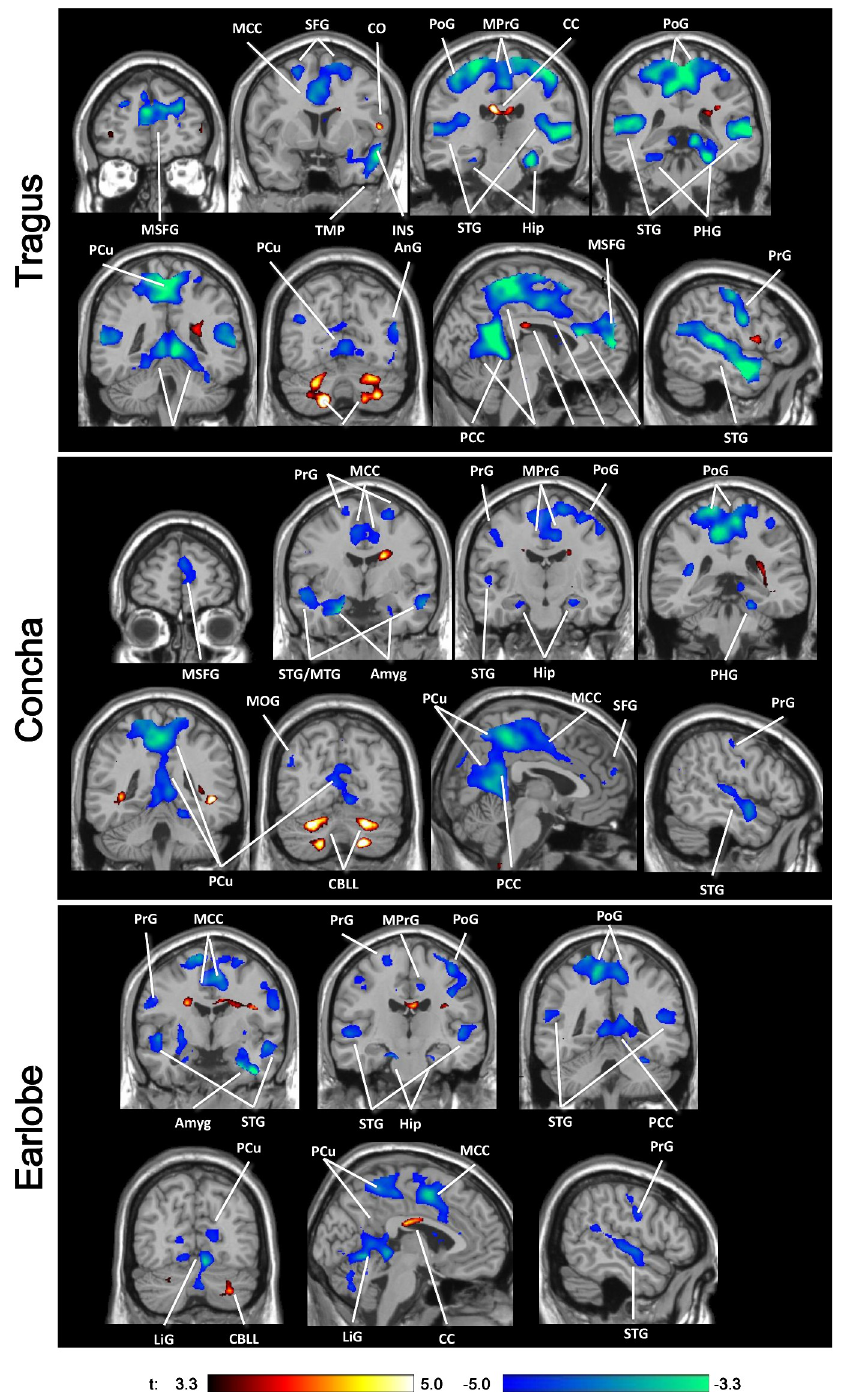
Fig 1. Activations (red) and deactivations (blue) induced by tVNS at the tragus, cymba conchae, and earlobe (p < 0.05, cluster corrected for multiple comparisons). tVNS: transcutaneous vagus nerve stimulation; ACC/MCC/ PCC: anterior/middle/posterior cingulate cortex; Amyg: amygdala; AnG: angular gyrus; CC: corpus callosum; CBLL: cerebellum; FuG: fusiform gyrus; Hip: hippocampus; LiG: lingual gyrus; MOG: middle orbital gyrus; MTG/STG: middle/superior temporal gyrus; PCu: precuneus; PoG/PrG: postcentral/precentral gyrus; SFG: superior frontal gyrus; TMP: temporal pole.